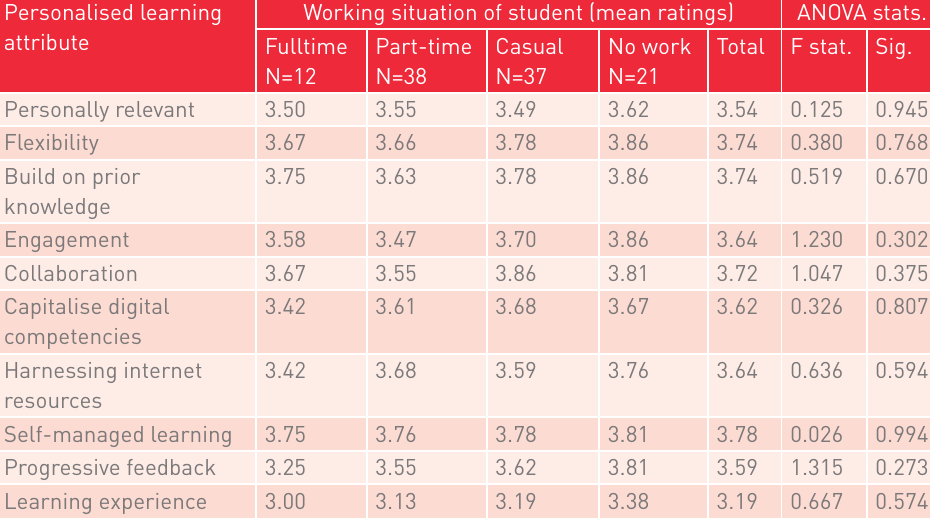
ANOVA test results for work situation of